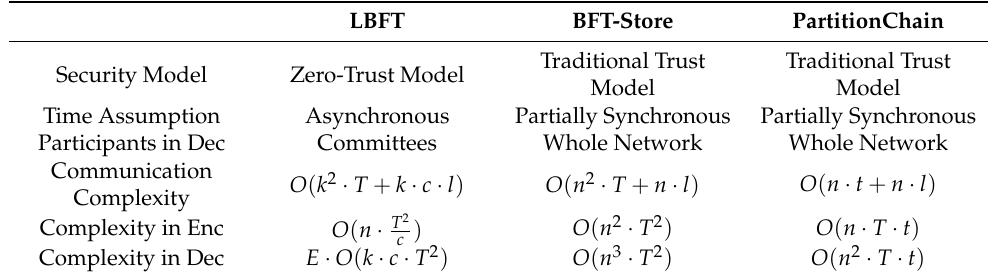
Table 1. The comparison of the performance between LBFT and BFT-Store. LBFT BFT-Store PartitionChain Traditional Trust Security Model Zero-Trust Model